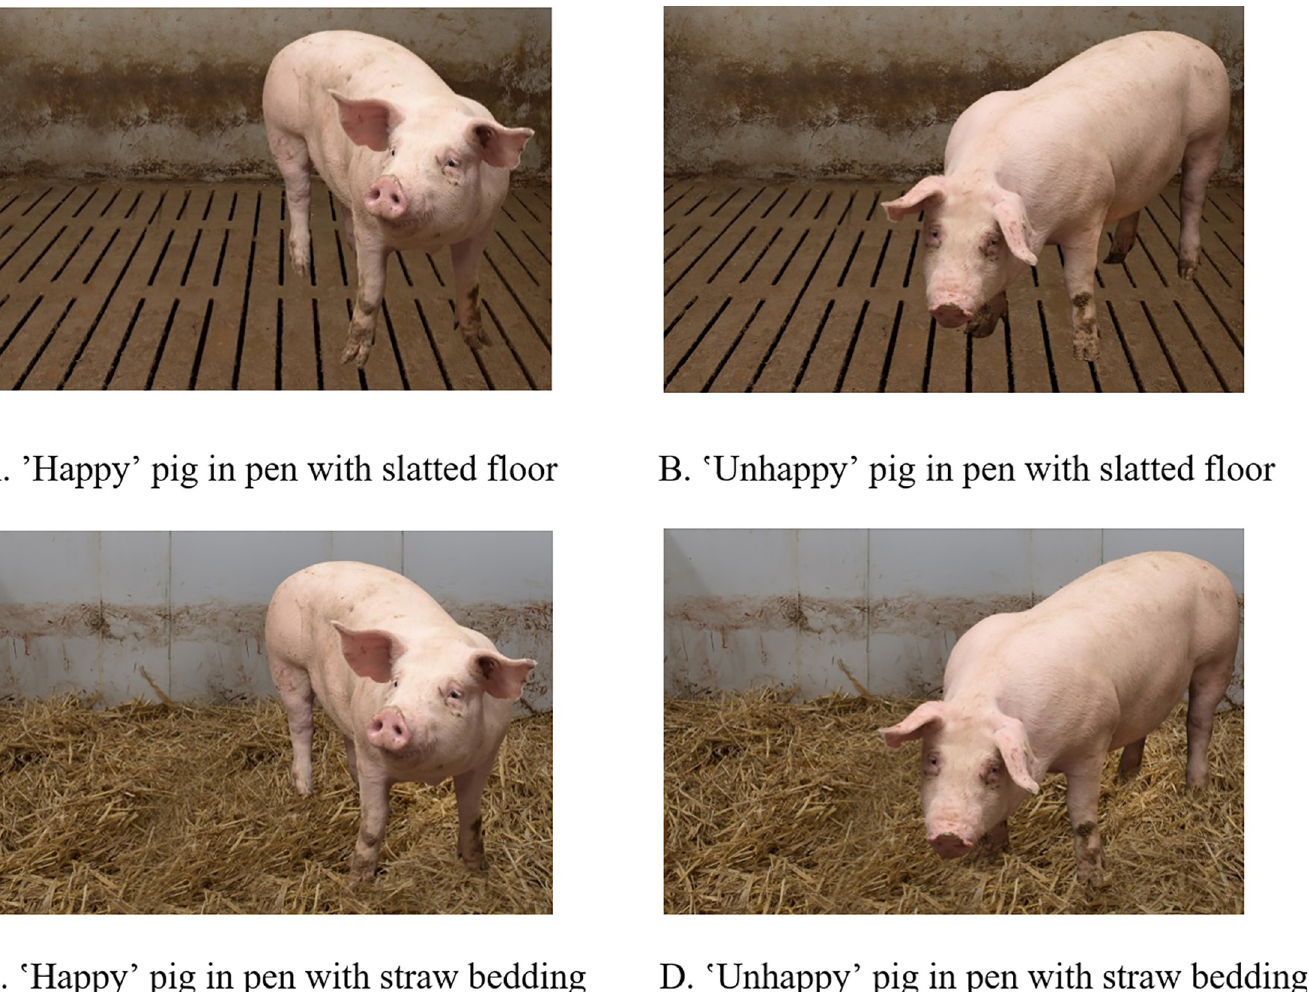
Fig 3. Combined pictures of pigs and pen settings presented as stimuli to survey participants. Source: Landpixel (Swen